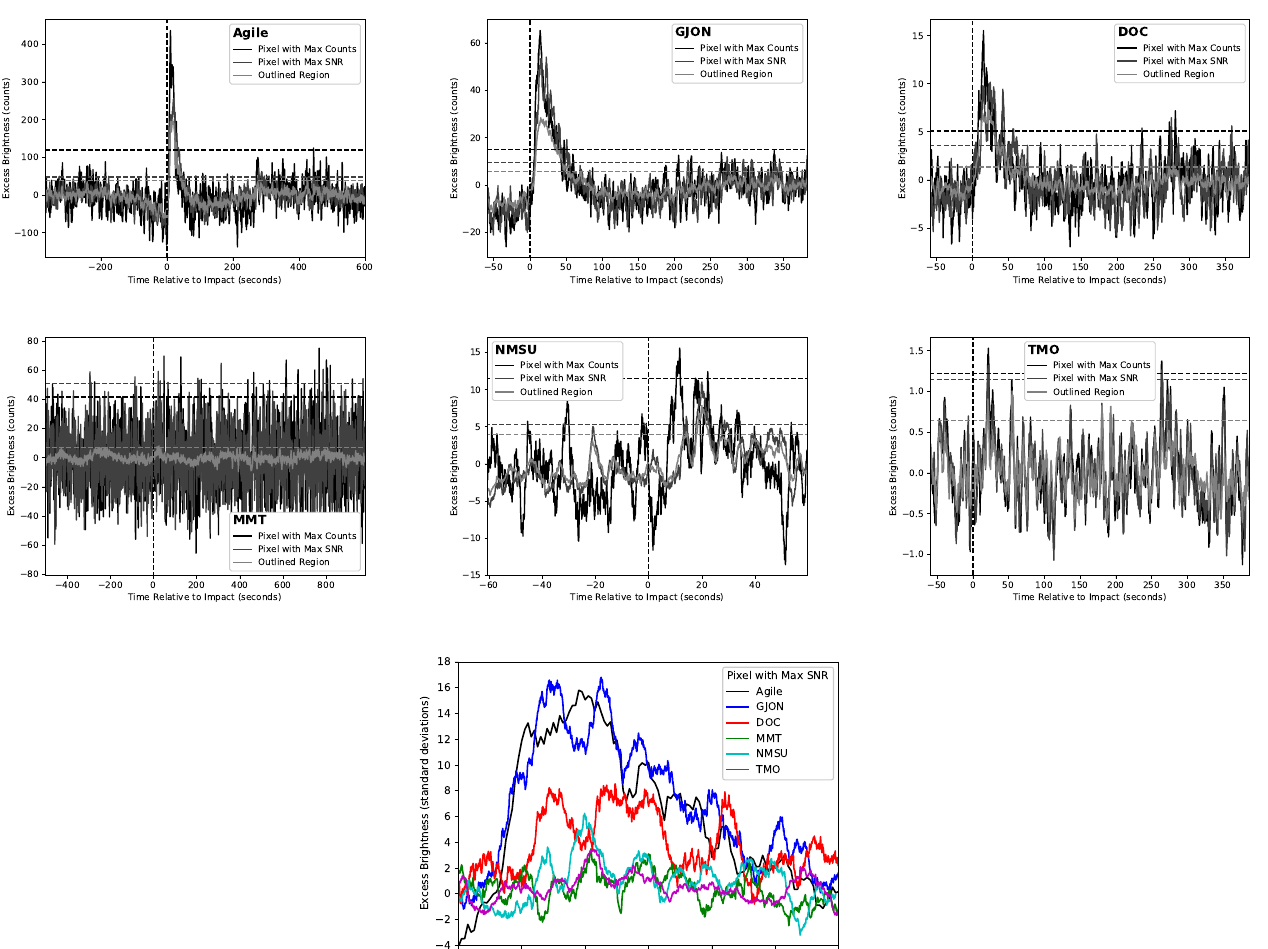
Figure 6. Lightcurves retrieved with the methodology of this work from the locations indicated in Figure 4. The small panels show the total duration of each observation. The horizontal dashed lines give the 3 σ level for each camera. In the lower panel, the excess brightness is shown scaled by signal strength in standard deviations for the first minute after